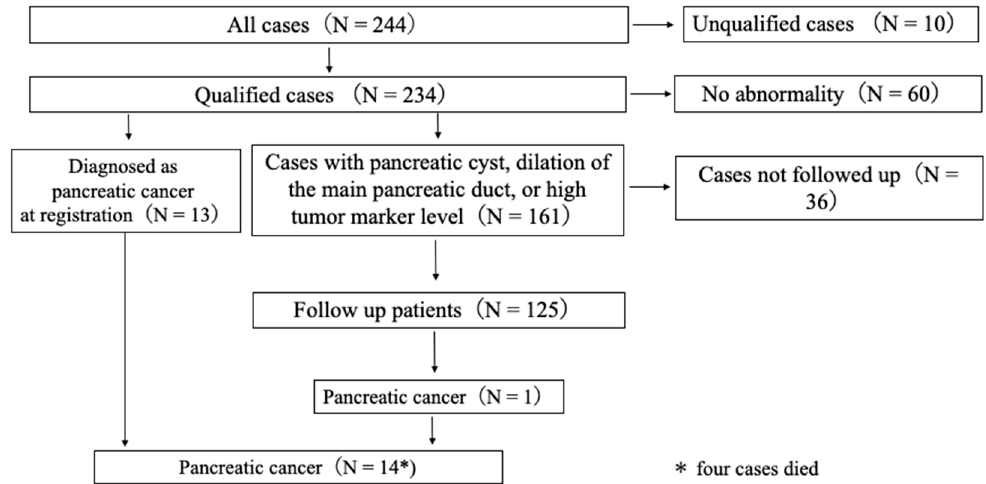
Figure 1. Patient participation flow and final diagnoses.